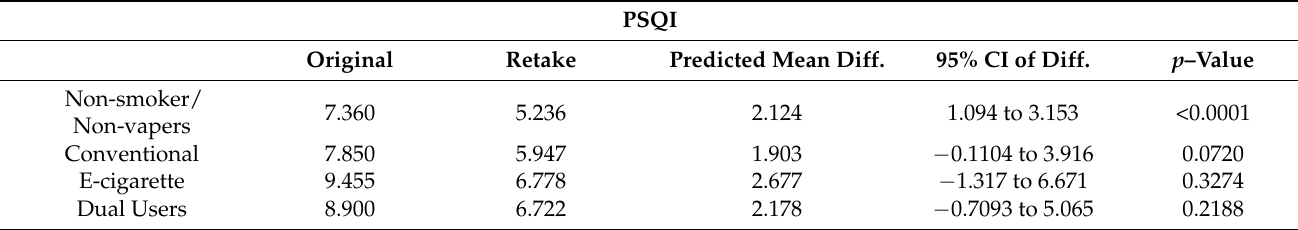
Table 2. PSQI Scored by Inhalant Group Comparing Original to